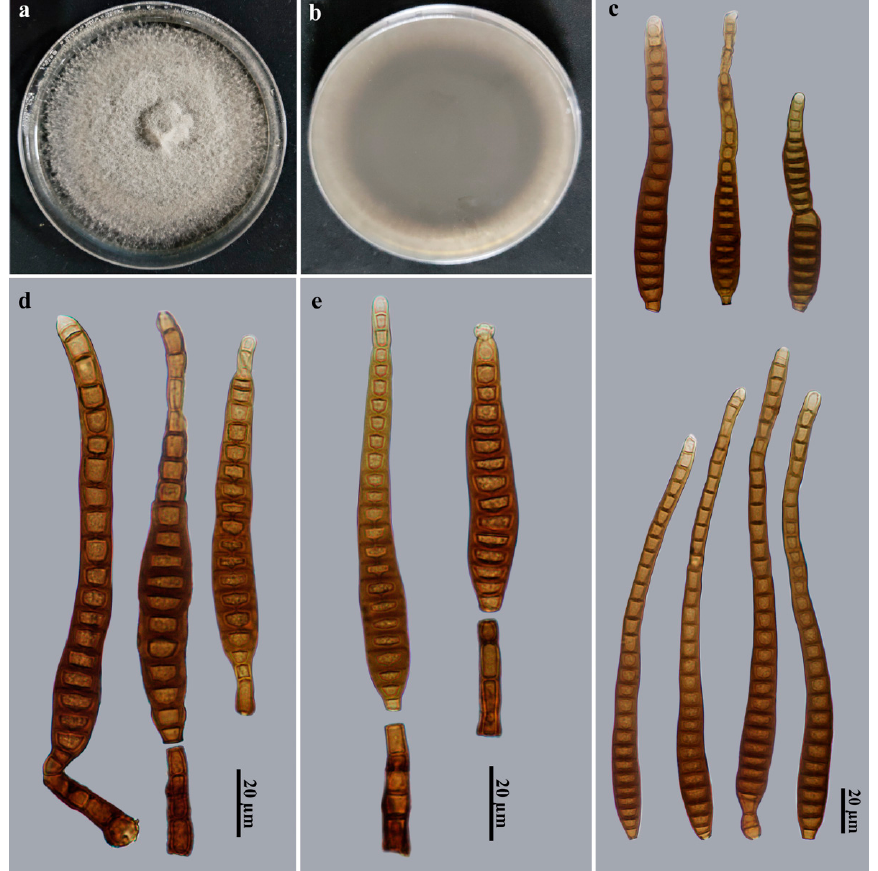
Figure 3. Distoseptispora nabanheensis (HJAUP M2003, holotype). ( a ) Surface of colony after 2 weeks on PDA; ( b ) reverse of colony after 2 weeks on PDA; ( c ) Conidia; ( d , e ) Conidiophores, conidiogenous cells, and conidia.